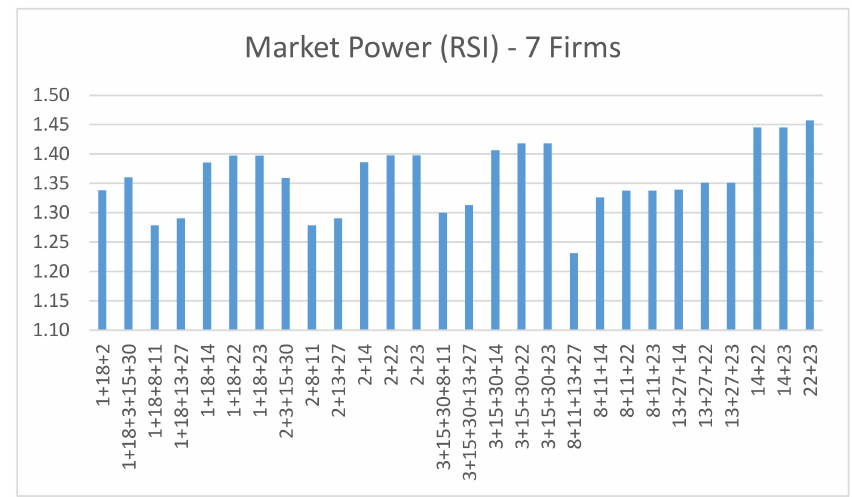
Figure 19. RSI for 7 firms’ setting (Cournot).